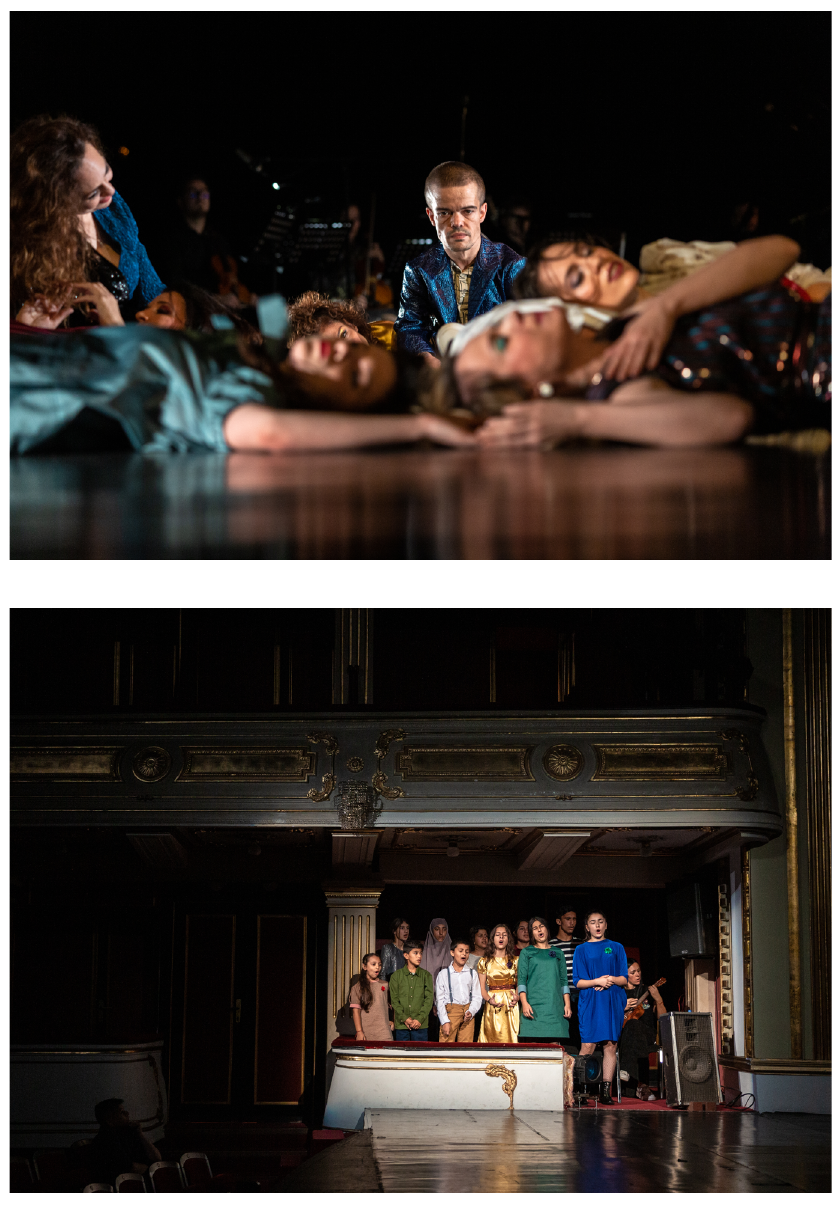
Fig. 1 and 2 – Children by Irena Popovi ć , National Theatre in Belgrade, 2022, © National Theatre in Belgrade